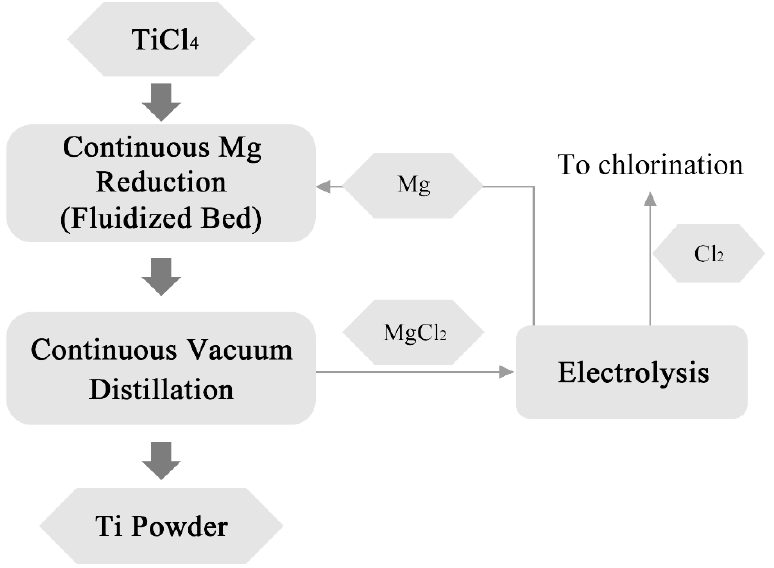
Figure 5. Flowchart of the TiRO process [52] (Adapted from [52], with permission from Elsevier, 2020).